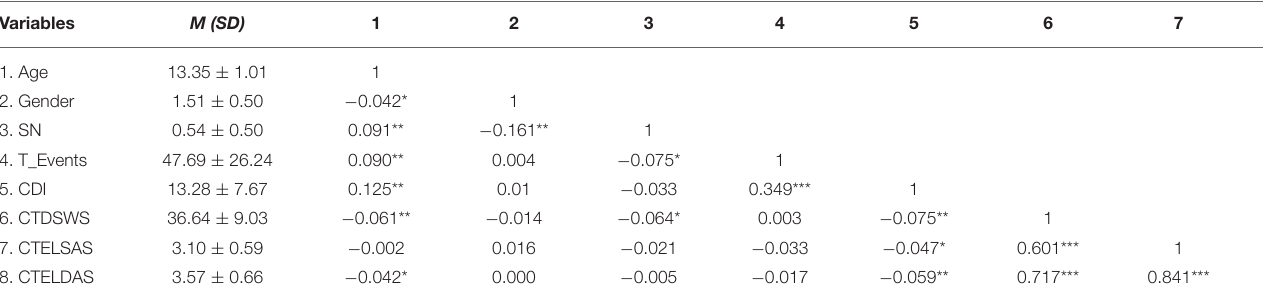
TABLE 1 | The variables’ mean, standard deviation and correlation coefficients.